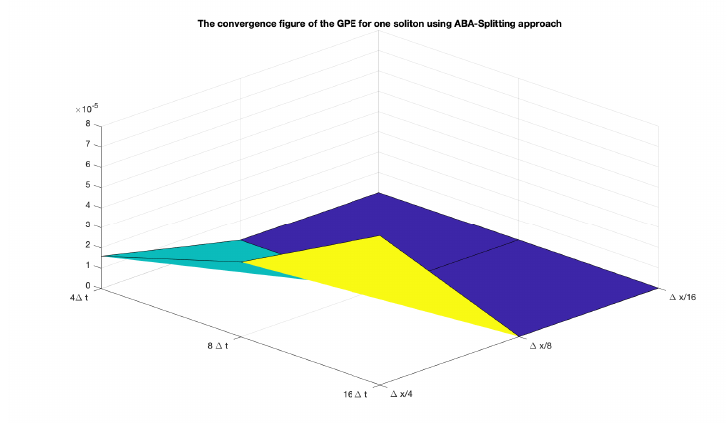
Figure 1. Results of the GPEwith one soliton equation, here we have applied the ABA-splitting approach (upper figure: numerical results; lower figure: convergence results).